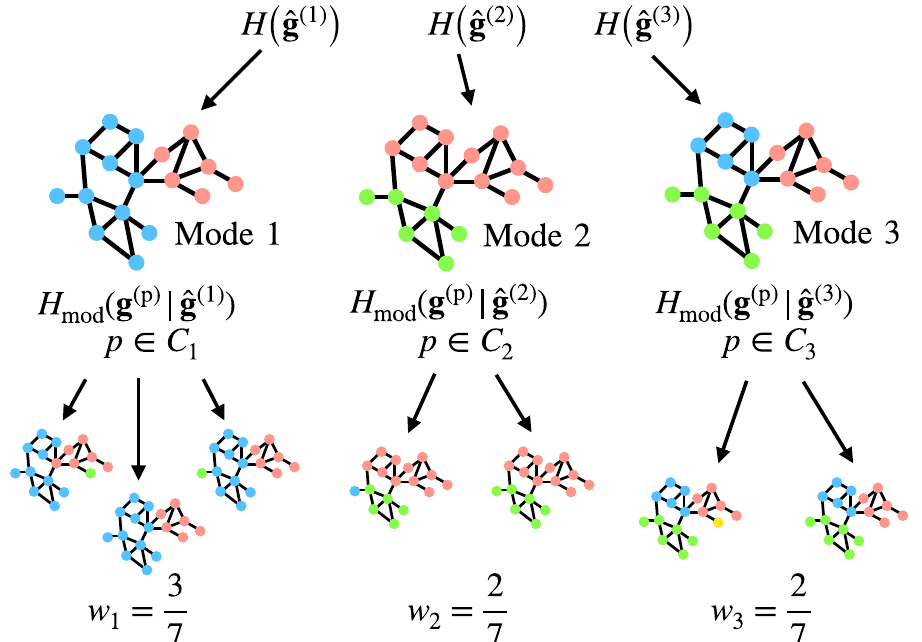
Fig. 1 Transmission of a set of partitions for a network. We fi rst transmit a small set of “ modes ” ^ g ð k Þ , archetypal partitions drawn from the larger set, which takes an amount of information equal to the sum of the entropies H of these partitions (Eq. (2)). Then each partition g ( p ) from the complete set is transmitted by describing how it differs from the most similar of the modes, which requires an amount of information equal to the modi fi ed conditional entropy H mod of Eq. (4). The weight w k is the fraction of all partitions that are part of cluster C k , the set of partitions assigned to the representative mode ^ g ð k Þ . The color of each node indicates its community membership within a